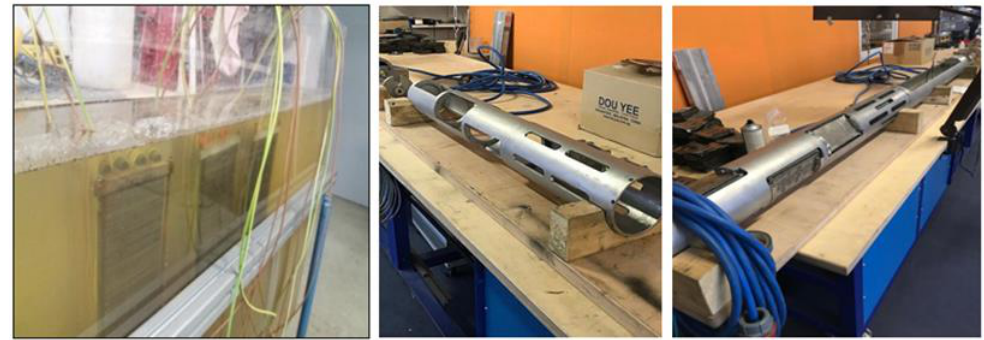
Figure 3. Laboratory testing of ultrasonic emitters (SONIC Technologies, GmbH, Sailauf, Germany)